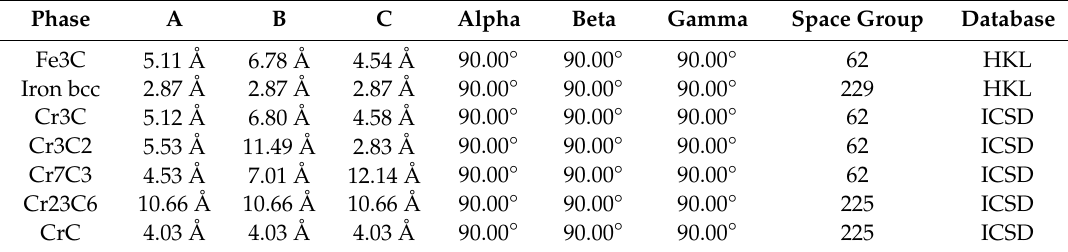
Figure 3. ( a ) SEM image of Type 420 ferritic stainless steel with EDX elemental maps of Cr, Fe, C, and Mn, and ( b ) high-resolution EBSD map highlighting chromium carbides (BCC = body centred cubic, ferritic matrix). Table 1. Database with crystallographic parameters for electron backscatter di ff raction (EBSD) phase identification from Inorganic Crystal Structure Database (ICSD) and the Aztec EBSD software (Version 4.2, Oxford Instruments, Abingdon,